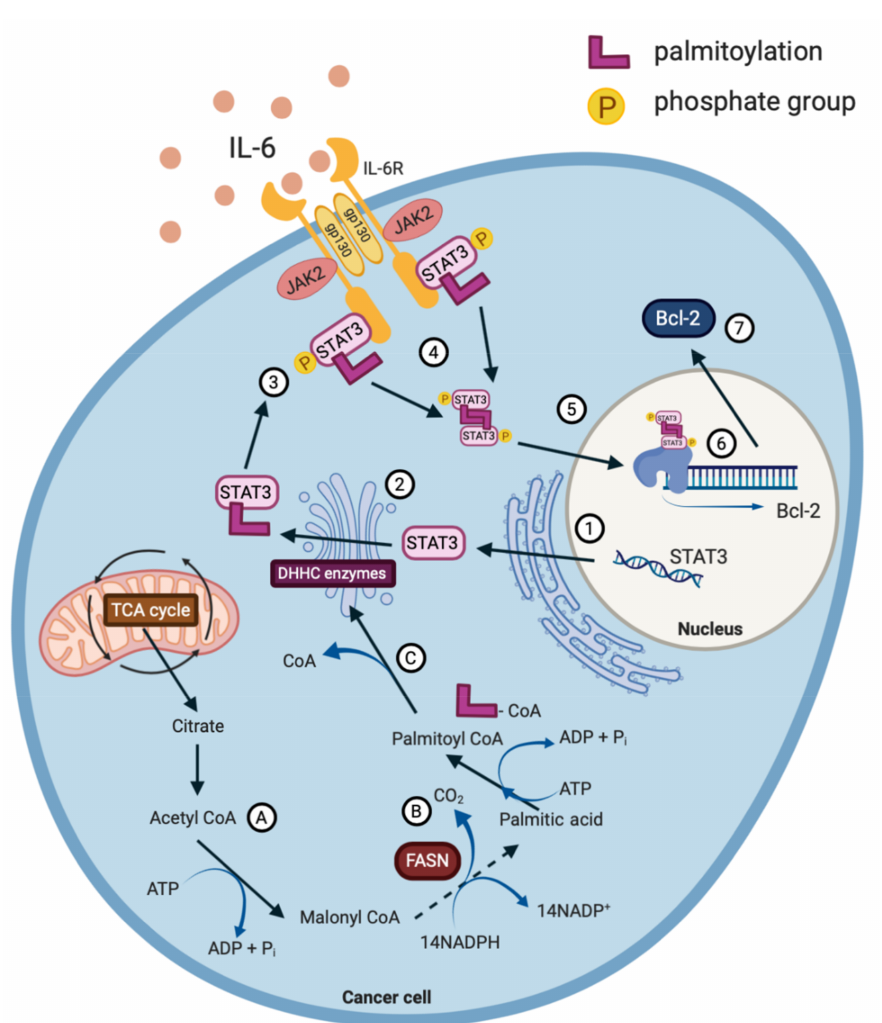
Figure 2. STAT3 is transcribed (1) and subsequently post-translationally palmitoylated by palmitoyl acyltransferase (DHHC) enzymes in the Golgi apparatus (2). IL-6R / JAK / STAT3 signalling is initiated at the plasma membrane by the formation of a hetero-hexametric complex (3), promoting the phosphorylation of STAT3 at Tyr705. Palmitoylated and phosphorylated STAT3 forms a dimer with the aid of the palmitoylation at the SRC homology 2 domain (4) before being translocated to the nucleus (5) and binding to the promoter regions of various oncogenes (6). For example, STAT3 binds to and upregulates the expression of BCL2 (7). The fatty acid moieties required for palmitoylation are synthesized from acetyl CoA (A) from the tricarboxylic acid cycle (TCA); with the help of the enzyme fatty acid synthase (FASN) (B); to yield various long chain fatty acids e.g. palmitic acid. Palmitate is subsequently converted to palmitoyl CoA which can then contribute to the palmitoylation of proteins within the Golgi apparatus